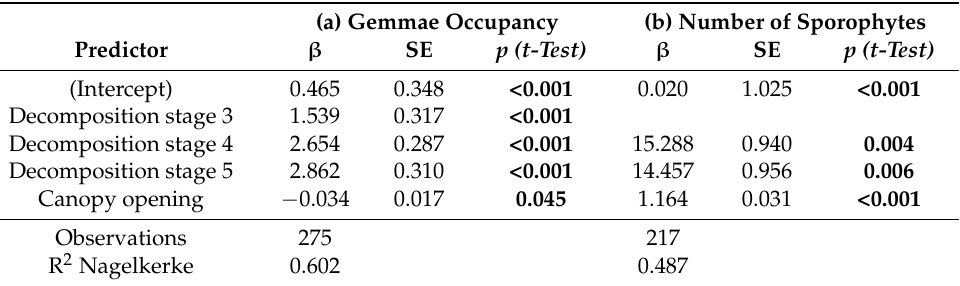
Table 4. Results of model regression after model simplification using stepwise selection procedure (model with the smallest AIC was chosen). The first model (a) tests the relationship between gemmae occupancy as a dependent variable, and environmental variables at microhabitat scale as independent variables. Model (b) is similar, except that the dependent variable is the number of sporophytes, and the model is a negative binomial regression. Only significant variables were retained in the final model (t-test, p < 0.05).